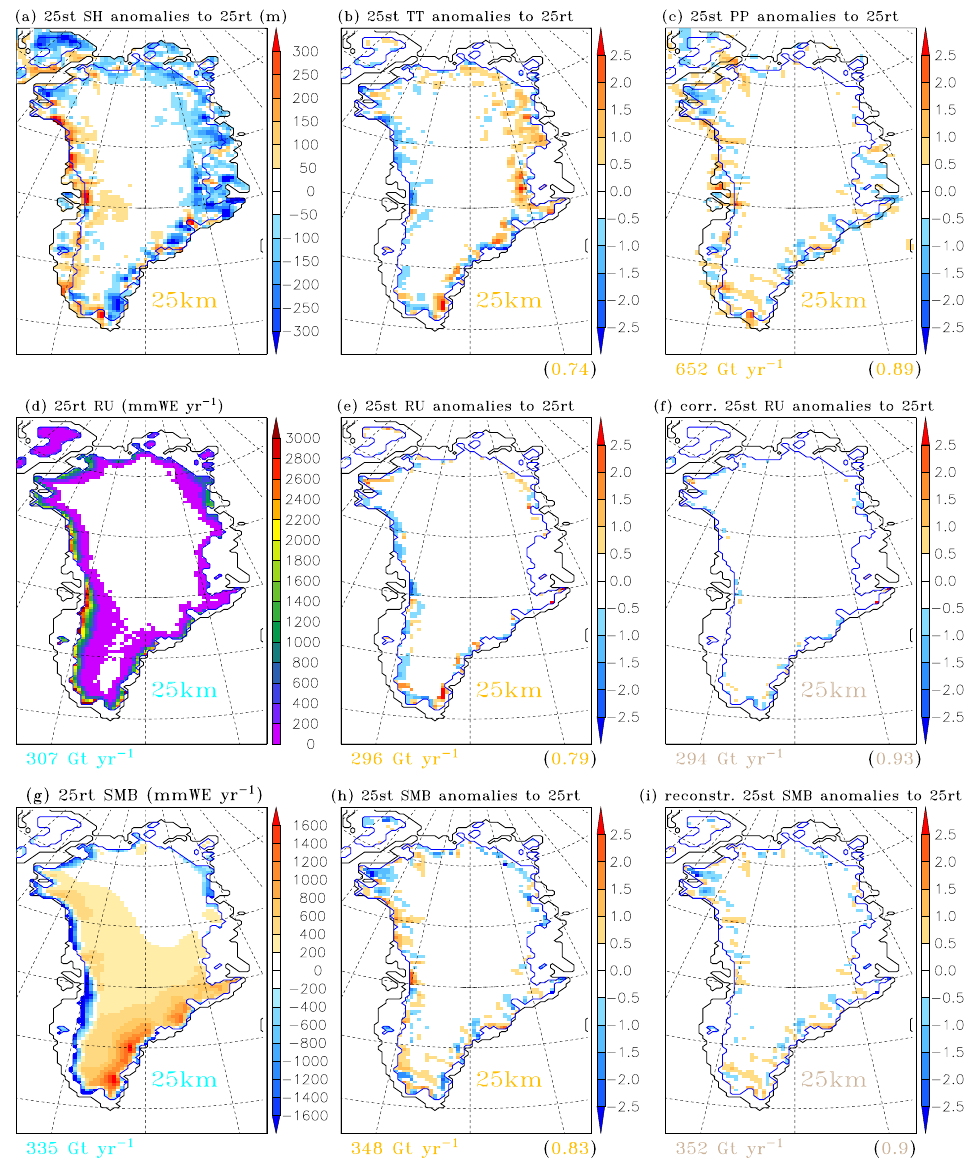
Fig. 8. (a) Surface height anomalies (m) of the 50km resolution MAR topography interpolated onto the 25km MAR grid (25st), compared to the original 25km topography (25rt). (b) Annual near-surface temperature anomalies (in standard deviation) of the 25st outputs compared to the 25rt outputs, over 1990–2010. On the bottom right side of the view, in brackets, is the skill score of 25st compared to 25rt. (c) The same as (b) , but for the annual precipitation anomalies (in standard deviation). On the bottom left side of the view is the annual amount of precipitation over the GrIS from 25st. (d) Annual meltwater run-off (mmWEyr − 1 ) provided by 25rt over the 1990–2010 period. (e) Annual run-off anomalies (in standard deviation) of the 25st outputs compared to (d) . On the bottom right side of the view, in brackets, is the skill score of the 25st run-off compared to (d) . (f) The same as (e) , but for the 25st run-off corrected by daily gradients. (g–i) The same as (d–f) , but for the annual SMB (mmWEyr − 1 ) simulated by the MAR model, and the reconstructed SMB from the corrected 25st outputs.